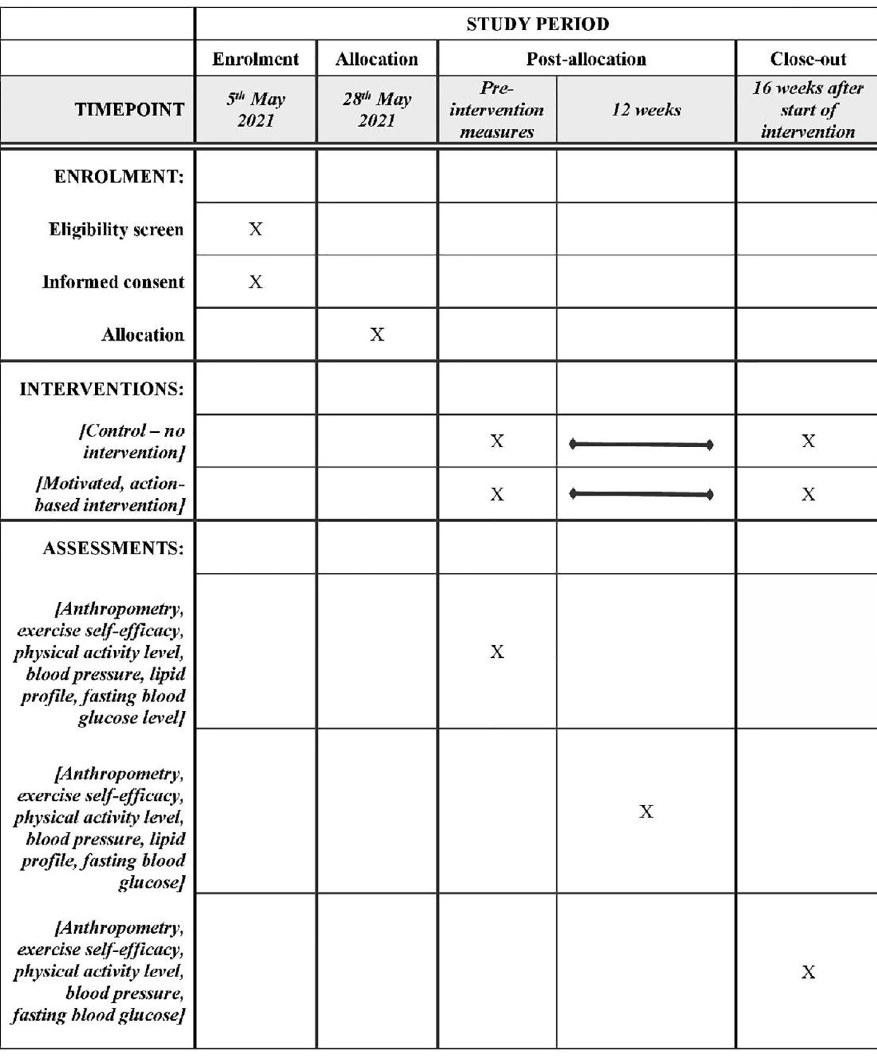
Fig 1. SPIRIT schedule of enrolment, intervention, and assessment of the